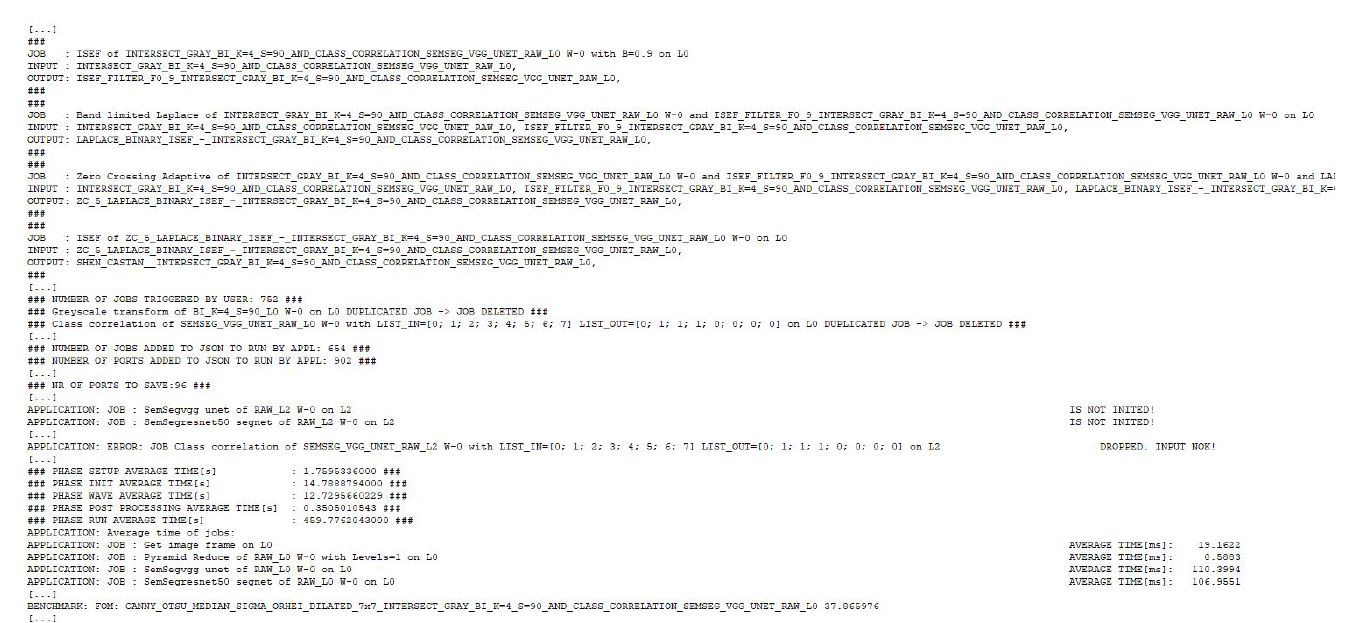
Figure 21. Console output of the